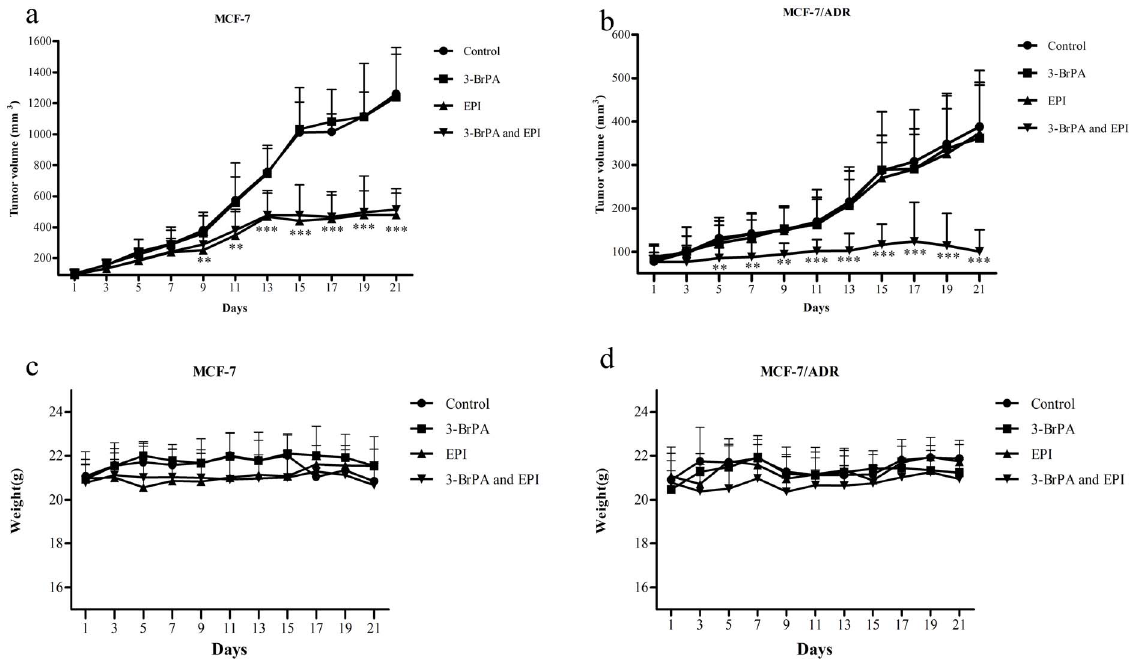
Figure 7. The MDR reversal effect of 3-BrPA on MCF/ADR xenograft model. The treatments were as follows: control (normal saline, q2d 6 11, iv); 3-BrPA (q2d 6 11, iv, 5 mg/kg); EPI (q2d 6 11, iv, 0.5 mg/kg); 3-BrPA (q2d 6 11, iv, 5 mg/kg) and EPI (q2d 6 11, iv, 0.5 mg/kg), 3-BrPA and EPI were dissolved in normal saline, and was given 1 h before EPI was injected, mean of tumor volume for each group (n=6) after implantation. Each point on line graph represents the mean of tumor volume (mm 3 ) at a particular day after implantation, and each bar represents SD. Potentiation of antitumor effects of EPI by 3-BrPA in ABCB-1/P-gp overexpressing MCF-7/ADR xenograft model is shown. a: Changes in the mean of tumor volume over the time course of the experiment in MCF-7 xenograft model. b: Changes in tumor volume over the time course of the experiment in ABCB-1/P-gp overexpressing MCF-7/ADR xenograft model are shown. c: Changes in the mean of body weight over the time course of the experiment in MCF-7 xenograft model are shown. d: Changes in the mean of body weight over the time course of the experiment in ABCB-1/P-gp overexpressing MCF-7/ ADR xenograft model are shown. *** P , 0.001 versus the control group; ** P , 0.01 versus the control group.